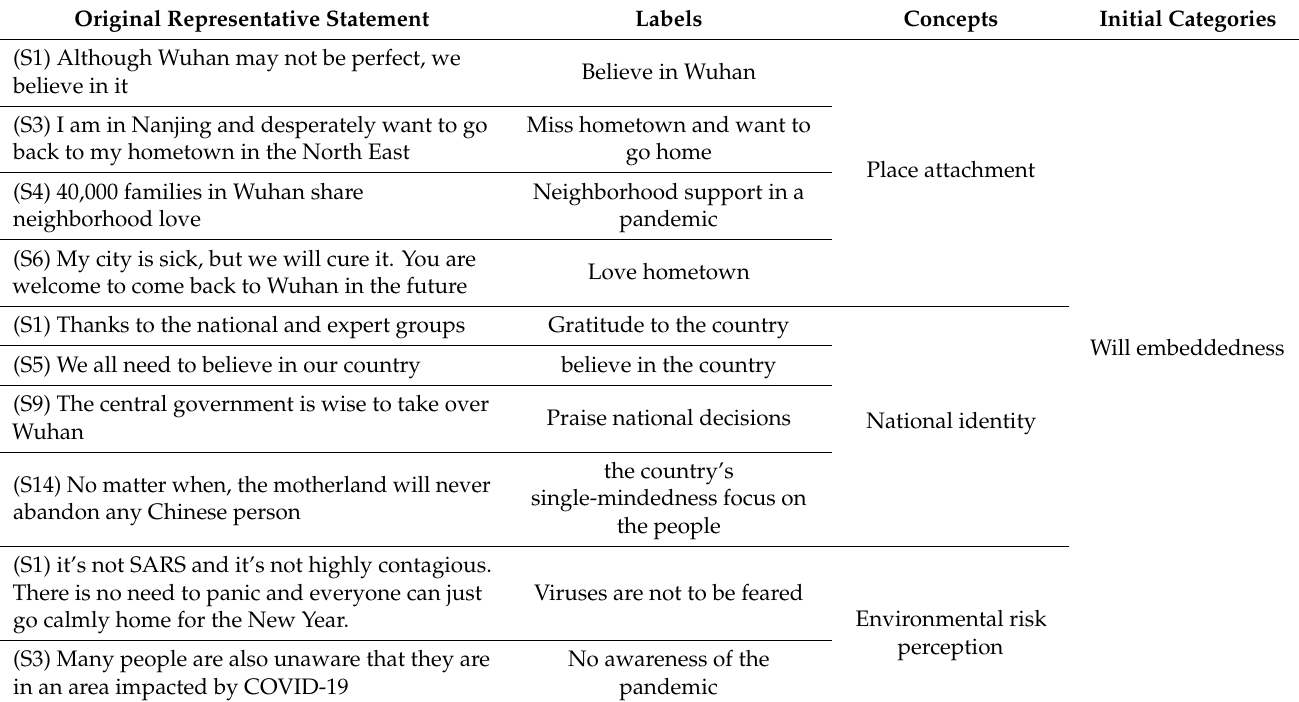
Table 3. Opening coding (excerpts).